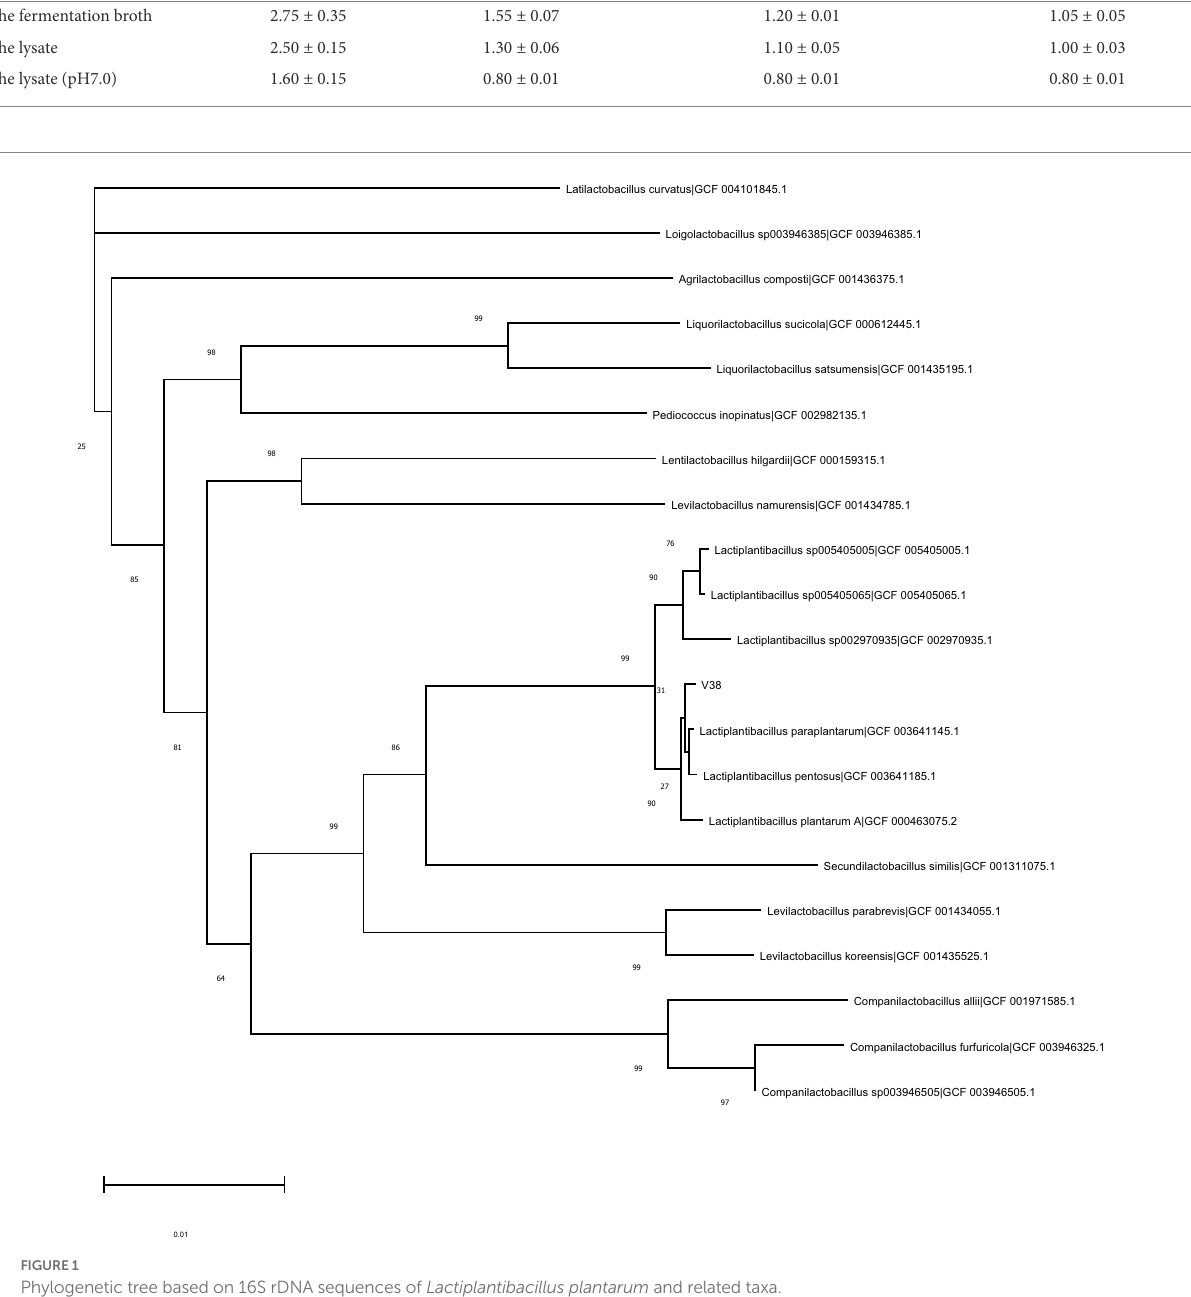
FIGURE 1 Phylogenetic tree based on 16S rDNA sequences of Lactiplantibacillus plantarum and related